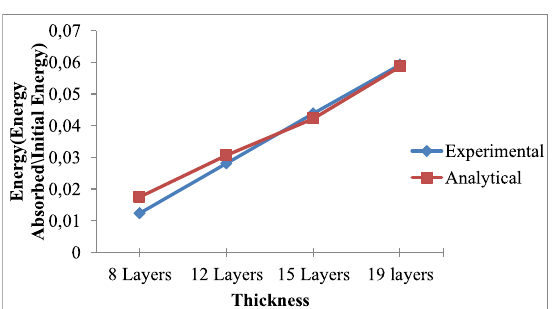
Figure 23. Comparison chart for variation in dimensionless parame- terwiththicknessofplatesfor0/90/45/-45lay-upobtained